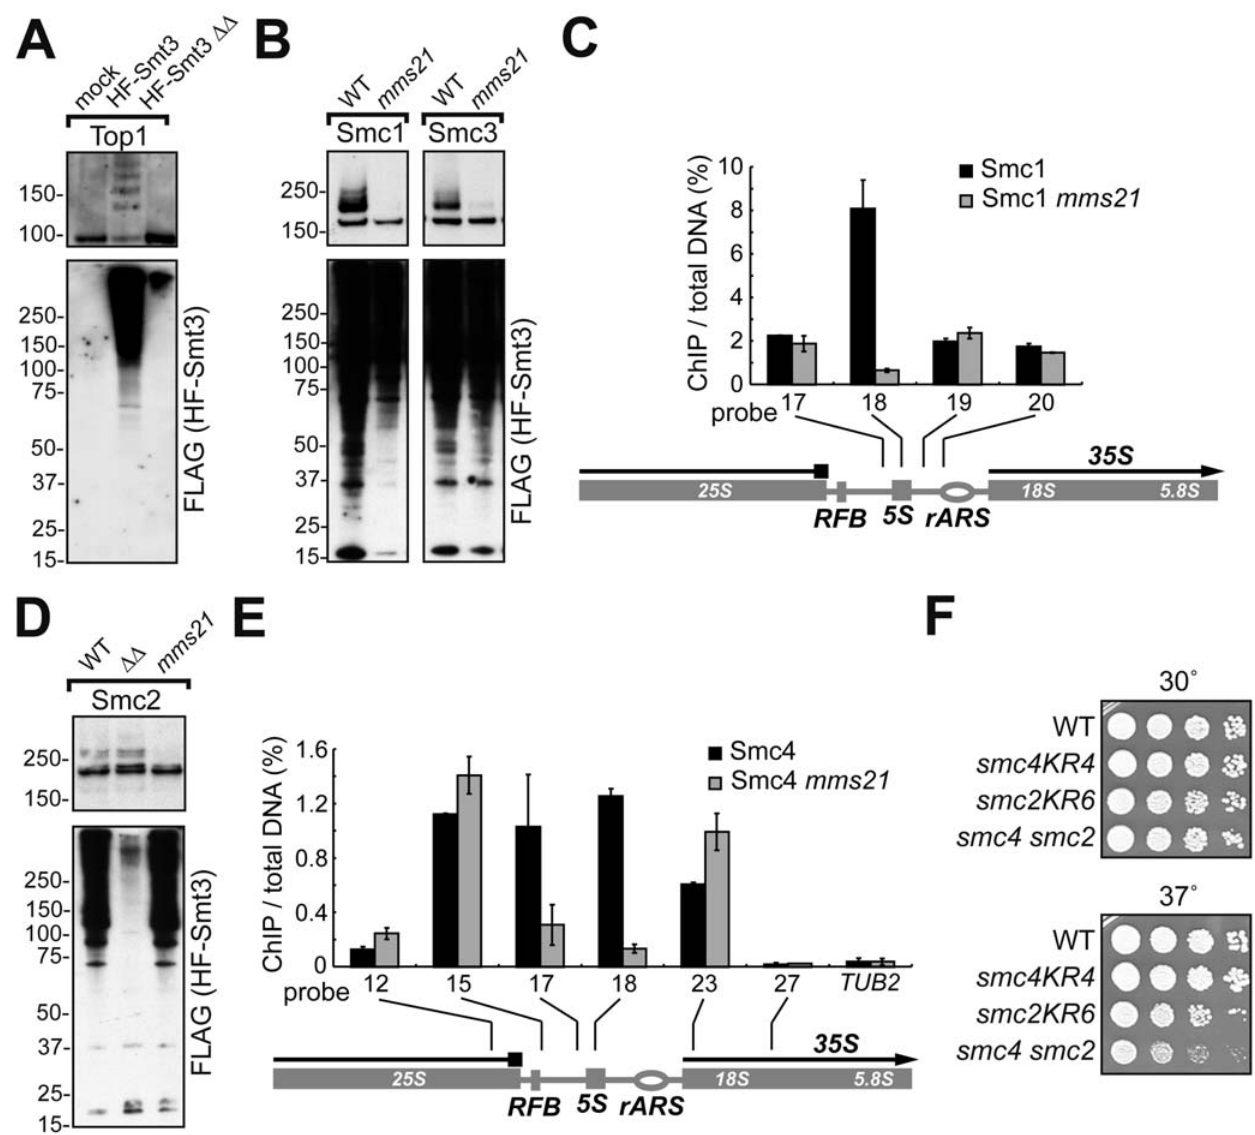
Figure 5. mms21-CH affects sumoylation and rDNA binding of cohesin and condensin. (A) Top1p sumoylation requires Siz1p/Siz2p. SUMO conjugates were purified from Siz + (924-1111-W303) or siz1 D siz2 D ( DD ,1aYT641) strains with tagged Top1p ( TOP1 :5HA) and SUMO ( HF-SMT3 ). Top1p was detected by the anti-HA (16B12) antibody. (B) Sumoylation of Smc1p and Smc3p is dependent on Mms21p. SUMO conjugates were purified from wild-type MMS21 ( SMC1 : 924-1131-W303, SMC3 : 924-1133-W303) or mms21-CH ( SMC1 : 1YT645, SMC3 : 1YT644) cells. Smc1p and Smc3p were detected by anti-HA antibody. (C) Smc1p lacking sumoylation exhibits altered rDNA binding. Wild type (924-1131-W303) and mms12-CH (1YT645) strains, both carrying HA-tagged Smc1p, were arrested by nococodazole and analyzed by ChIP/qPCR using the set of probes covering the whole rDNA repeat [45]. Only the probes relevant to the known cohesin enrichment peak [42,61] and negative controls are shown. (D) Sumoylation of Smc2p is dependent on Mms21p but not on Siz1p/Siz2p. SUMO conjugates were purified from wild type, siz1 D siz2 D ( DD , 1bYT642) and mms21-CH (1cYT643). Smc2p was detected by the specific anti-Smc2p antibody [41]. (E) Smc4p has reduced enrichment at the 5S rRNA gene in mms12-CH . The wild type (924-1134- W303) and mms12-CH (1YT646) strains, both carrying HA-tagged Smc4p, were arrested by nocodazole for 3 hr at 30 u C and analyzed by ChIP/qPCR using the set of probes covering the whole rDNA repeat as described in [45]. Only the probes relevant to the known condensin enrichment peaks [45] and negative controls are shown. (F) Mutations of potential sumoylation sites of Smc2p and Smc4p lead to synergistic growth defects. Wild type (W303), smc2KR6 (1146-YT656), smc4KR4 (1YT657), and double-mutant smc2KR6 smc4KR4 (1YT658) strains were tested for growth at 30 u C and 37 u C.